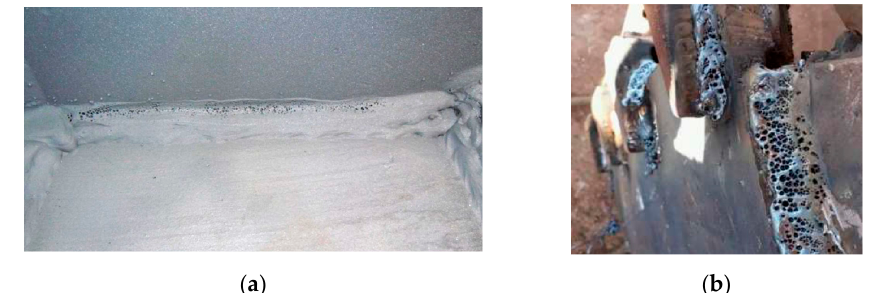
Figure 4. Porosity: ( a ) surface porosity uniformly distributed along the weld seam is produced because the displacement angle is too large (excessive slope); ( b ) porosity occurred because the gun is too far away from the workpiece or the voltage has been insufficient at the welding distance.